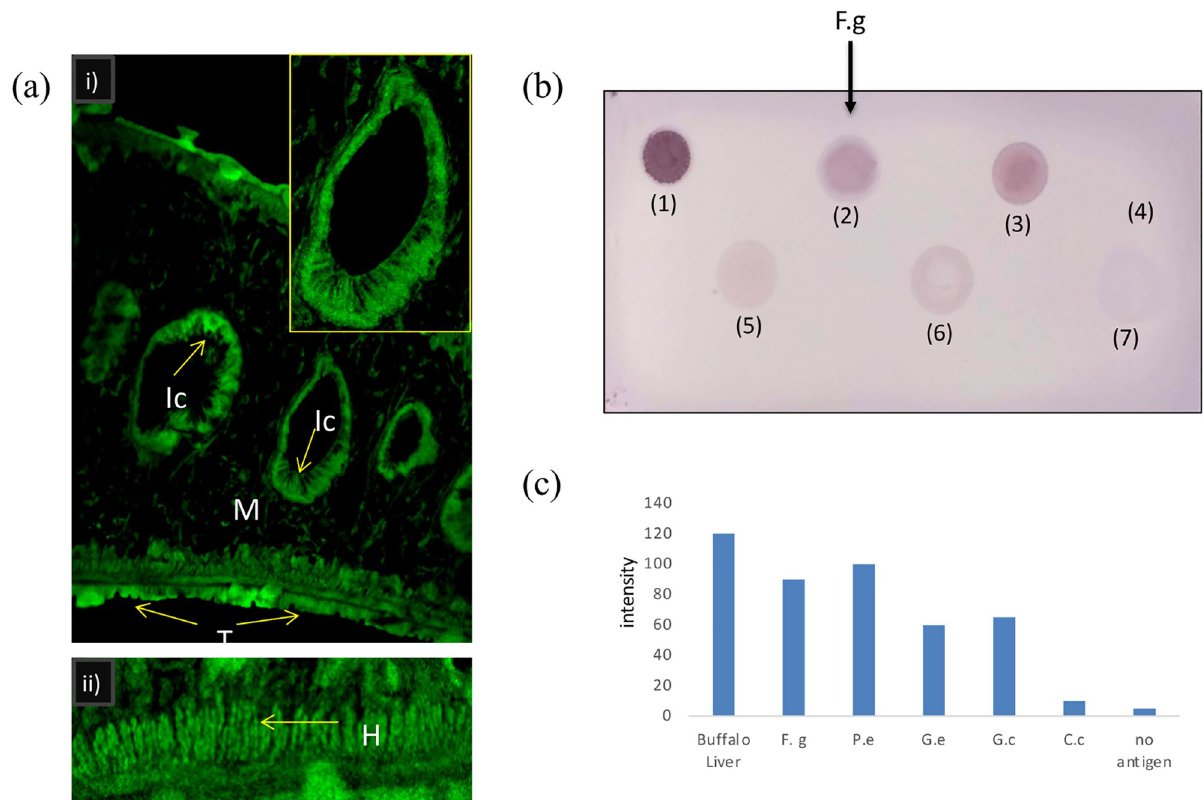
Fig 5. Confocal micrographs of tissue sections of adult tropical liver fluke F . gigantica (a). MAO-A was predominetly localized in the intestinal caecae, tegument, musculature and hypodermis using anti MAO-A polyclonal antibodies (i), inset showing magnified image of intestinal caecae. A magnified micrograph showing immunolocalization in hypodermis region (ii). Scale~200 μ m. (T- tegument, Ic- Intestinal caecae, H- hypodermis, M- musculature). (b) Representative dot blot with most intensely colored dot appeared in case of buffalo liver (1) followed by F . gigantica (2) and P . epiclitum (3) while C . complanatum (7) showed very low signal as compared to liver. The negative control was devoid of any antigen (4). (c) Quantification of intensity of samples of Dot-blot assay.